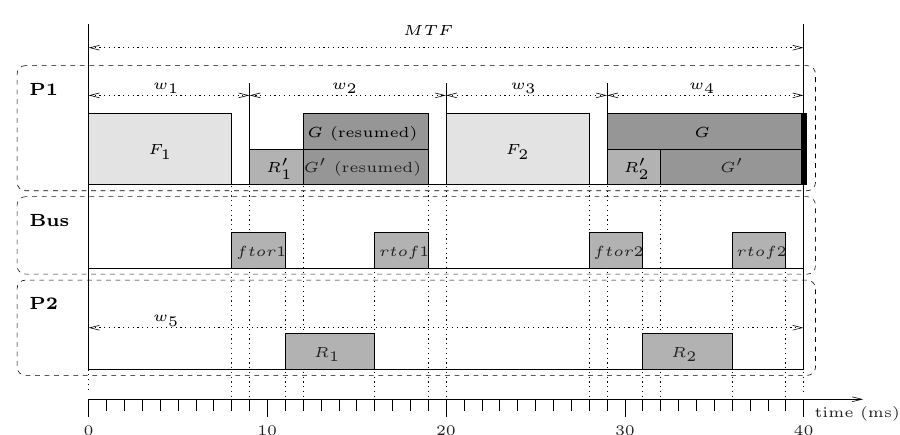
Figure 2 An example of time-triggered partitioned system. In this example only processor P1 requires